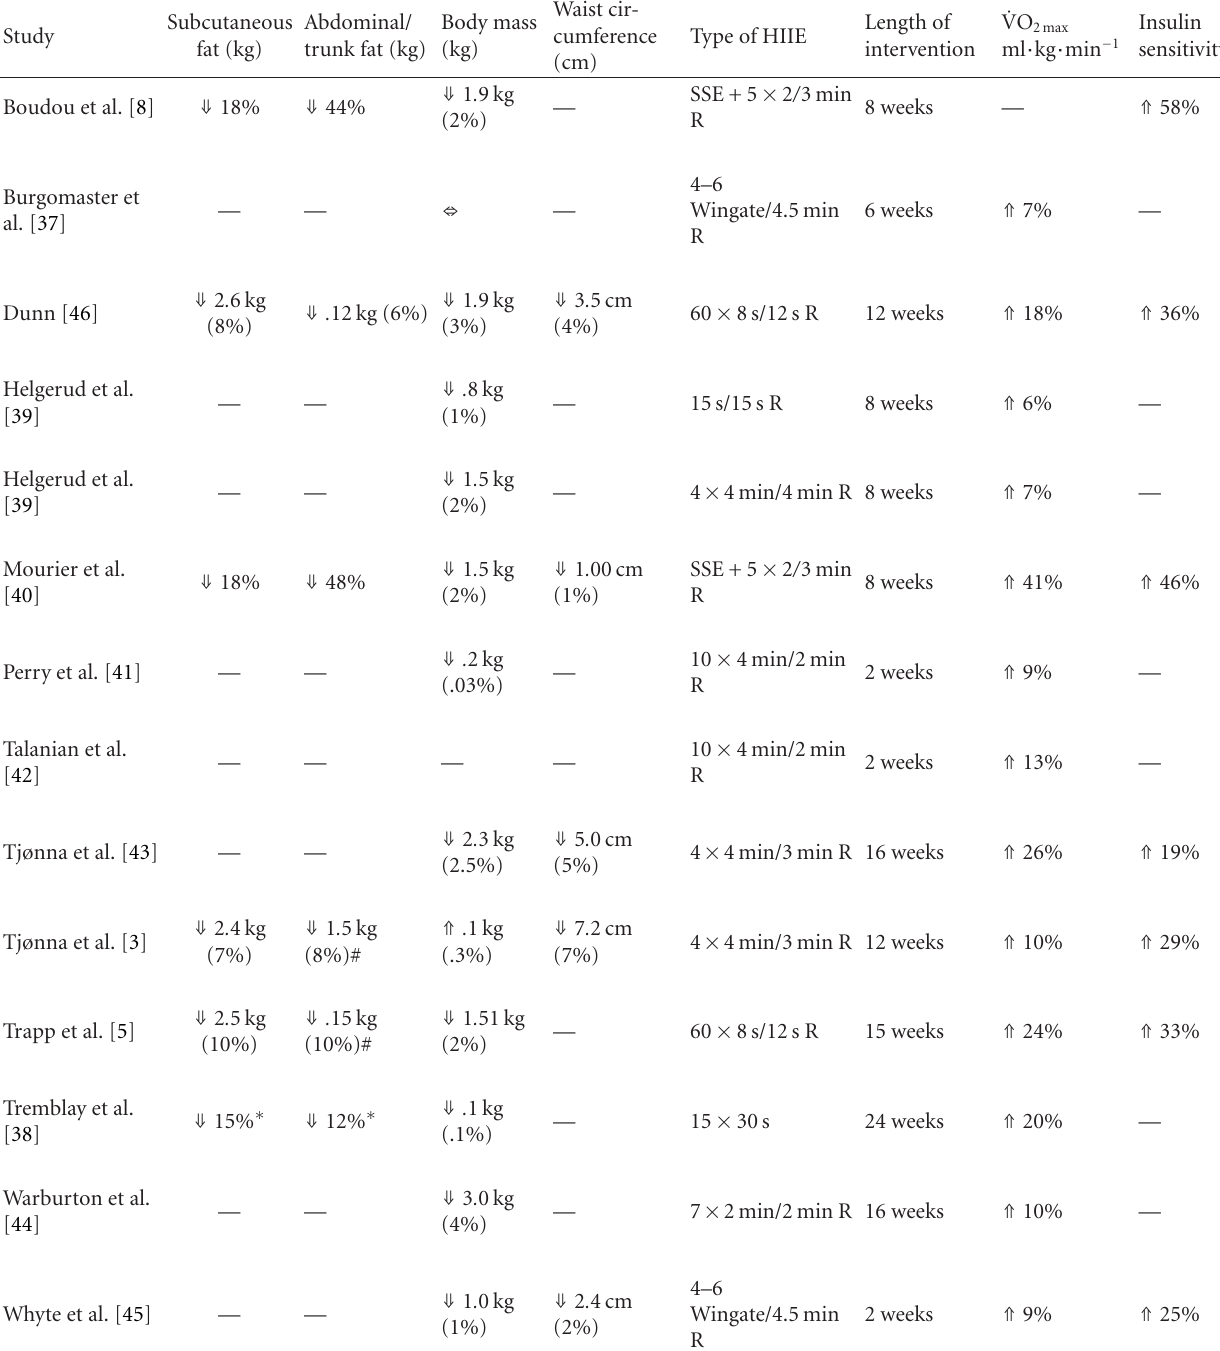
Table 1: E ff ect of high-intensity intermittent exercise on subcutaneous and abdominal fat, body mass, waist circumference, ˙VO 2max , and insulin